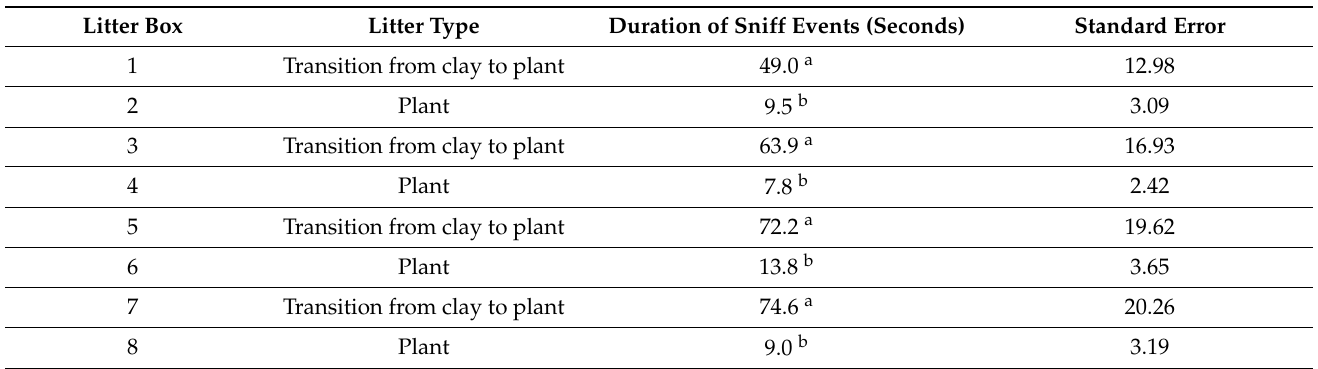
Table 3. Mean total duration of sniff events per litter box over the 6-day transition